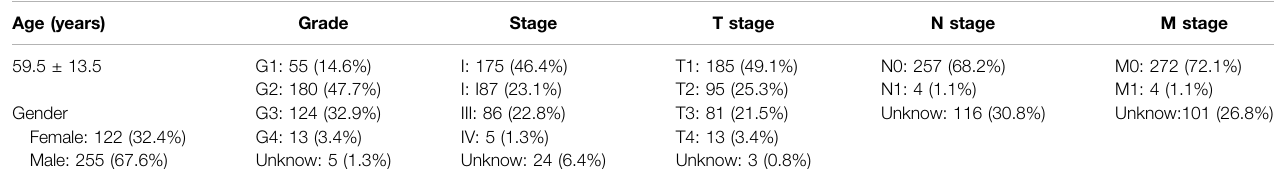
TABLE 1 | Clinicopathological features of patients from TCGA cohort ( n = 377). Age (years) Grade Stage